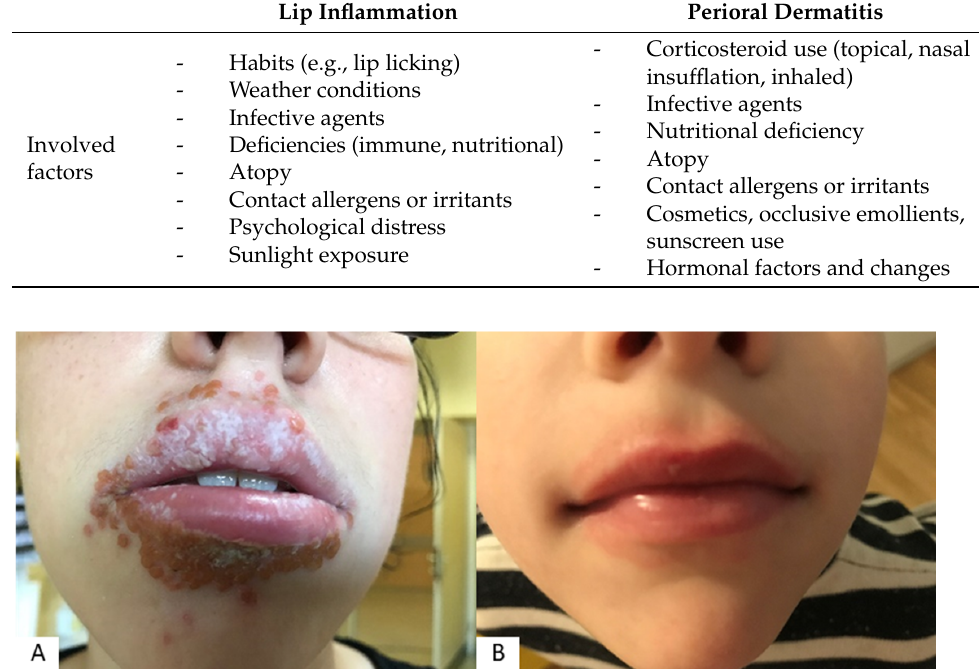
Table 1. Key factors participating in the occurrence of inflammation of the lips (cheilitis) and perioral skin.